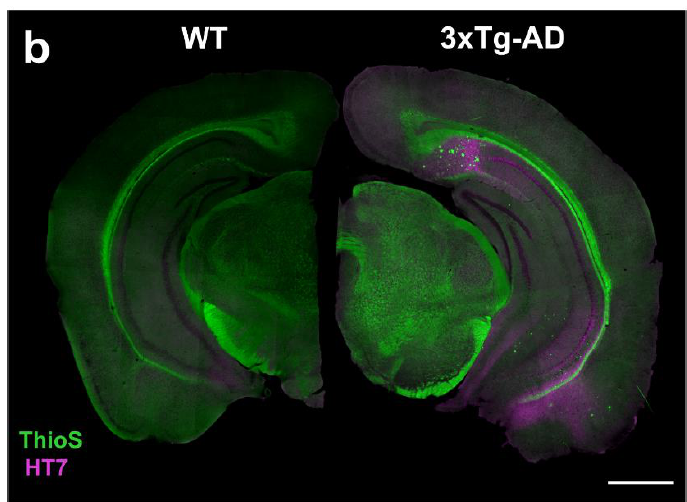
Figure 2. WT and transgenic female mice histological staining. ( a ) Staining in 5xFAD females at 18 months of age demonstrated a high load of β -amyloid plaques (Thioflavin-S) throughout the brain accompanied by elevated microglial activation (IBA-1) that was not observed in WT mice. ( b ) Staining for human Tau (HT7) as well as β -amyloid plaques (Thioflavin-S) in 18-month-old 3xTg-AD females revealed a more focal staining pattern compared to the 5xFAD model at the same age. Note the relative absence of β -amyloid plaques in the 3xTg-AD mice. Scale bar = 1 mm. (Images courtesy of K. Green, UCI MODEL-AD Consortium).